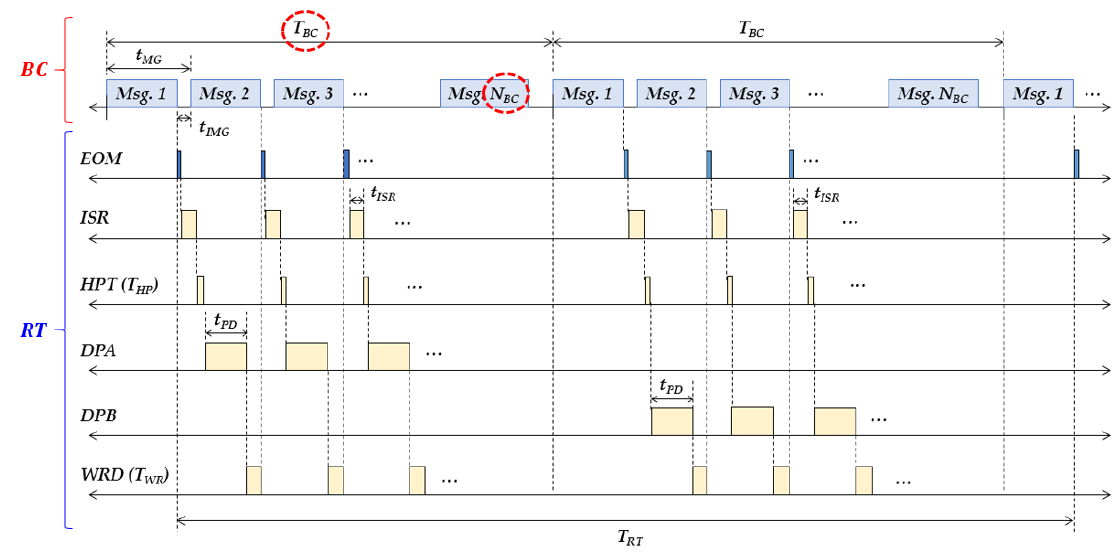
Figure 2. The timing diagram of the data transmission with multiple message chains (MMCs) and the data processing in a RT with double buffers. The end-of-message (EOM) occurs whenever a message is transmitted from the BC to the RT. In the RT, the data processing for the current MMC in a buffer should be finished until the next MMC is received in the same buffer to avoid data loss.